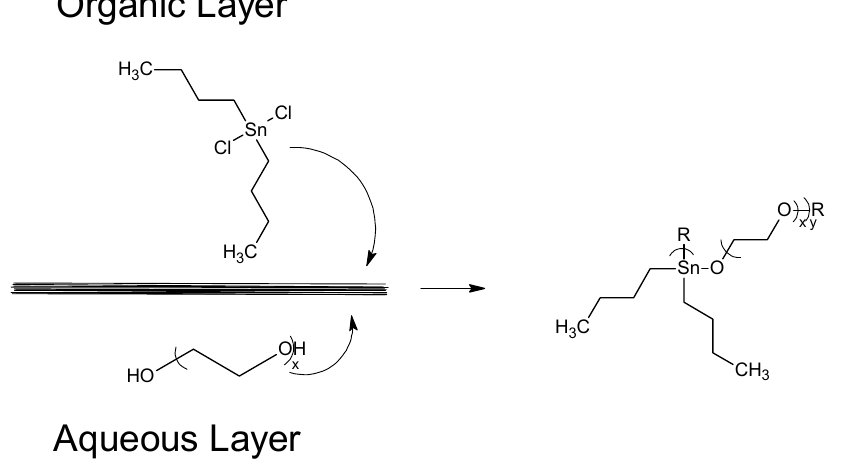
Figure 1. Description of the interfacial polycondensation system employed to synthesize water-soluble organotin polyethers, where x represents the PEG chain length and y represents the polymer’s average degree of polymerization (PEG: Poly(ethylene